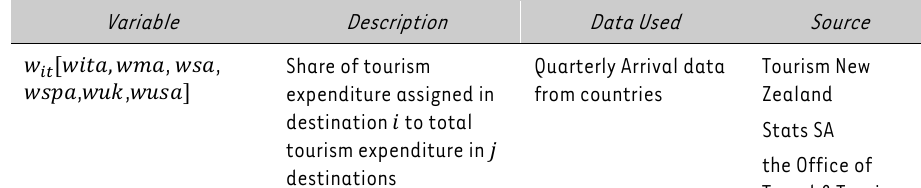
Variables, description of the data and